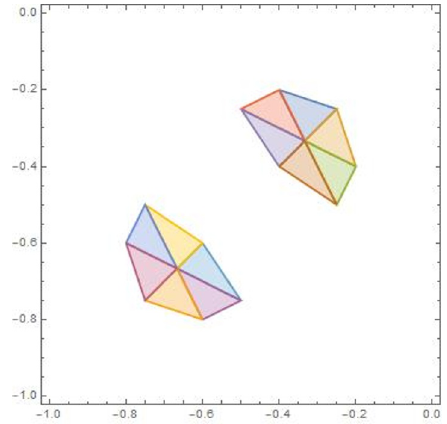
Figure 5 . The additional brackets [ − 2 φ 1 , 2 − φ 2 , 1 ] and [ φ 1 − φ 2 ] divide the blue and yellow domains both into six new domains, and the unrefined points lie at the intersection of these